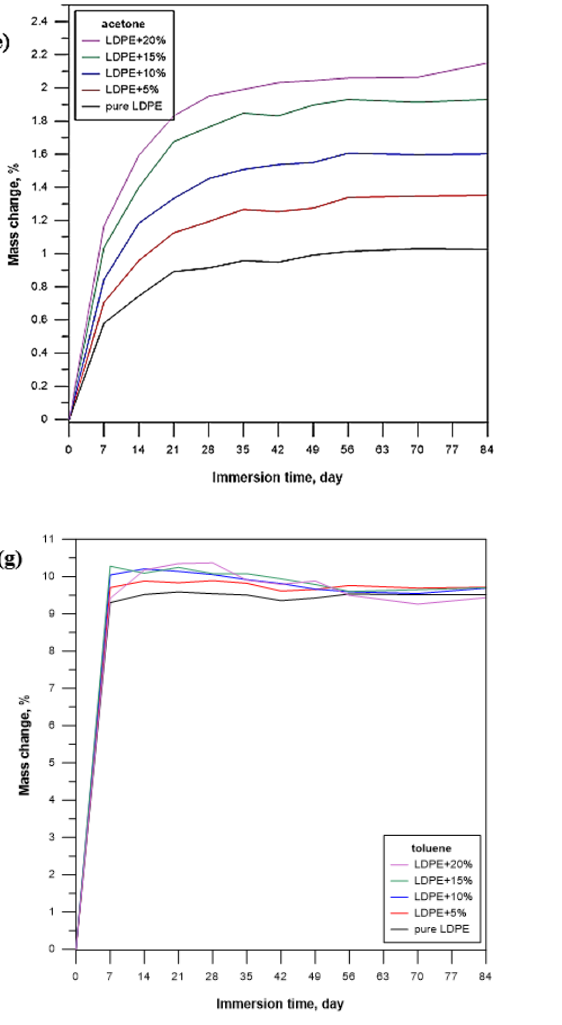
Figure 3. Mass change in pure LDPE and LDPE with a natural filler versus different solvents: ( a ) distilled water—filler grain size: 0.2–0.4 mm, ( b ) distilled water—filler grain size: 0.6–0.8 mm, ( c ) NaOH solution—filler grain size: 0.2–0.4 mm, ( d ) NaOH solution—filler grain size: 0.6–0.8 mm, ( e ) acetone—filler grain size: 0.2–0.4 mm, ( f ) acetone—filler grain size: 0.6–0.8 mm, ( g ) toluene—filler grain size: 0.2–0.4 mm, ( h ) toluene—filler grain size: 0.6–0.8 mm.